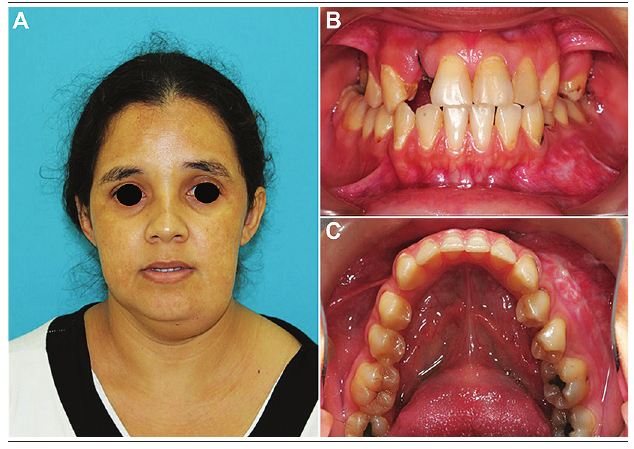
A) extraoral photography in which there is evidence of increase in left mandibular volume; frontal (B) and occlusal (C) intraoral photography, showing an increase in the mandibular body volume, reduction in the depth of vestibular sulcus and integrity of the alveolar mucosa.